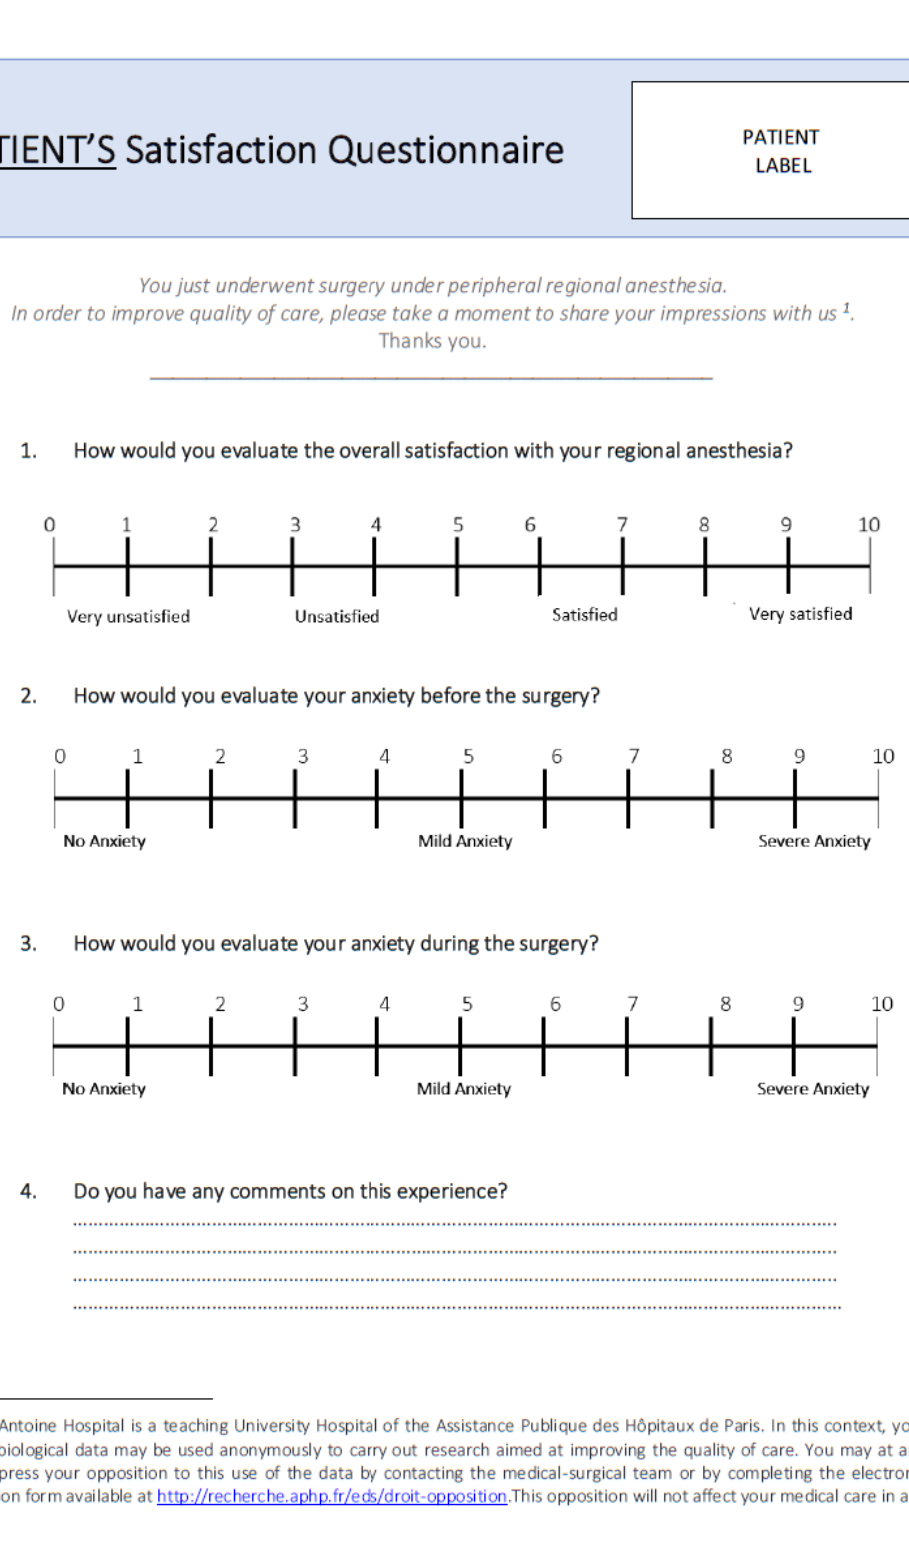
Figure A2. Postoperative satisfaction questionnaire.